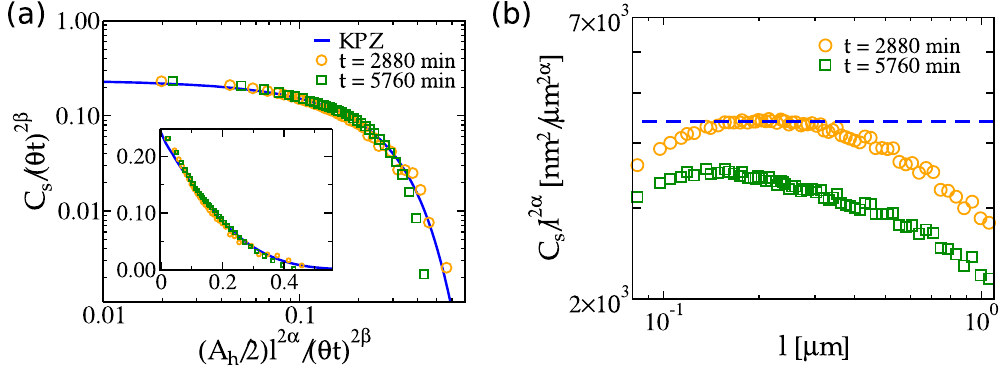
Figure 5. ( a ) Rescaled spatial covariance for KPZ class 15 (solid line) compared with the ones for CdTe surfaces (symbols). Inset shows the same data in linear scale. ( b ) Rescaled height difference correlation function C h / l 2 α versus l for CdTe surfaces at long times. The dashed line indicates the estimate of A h for t = 2880 min. Rescaling were performed using α = 0.3869 53 and β = 0.241 54